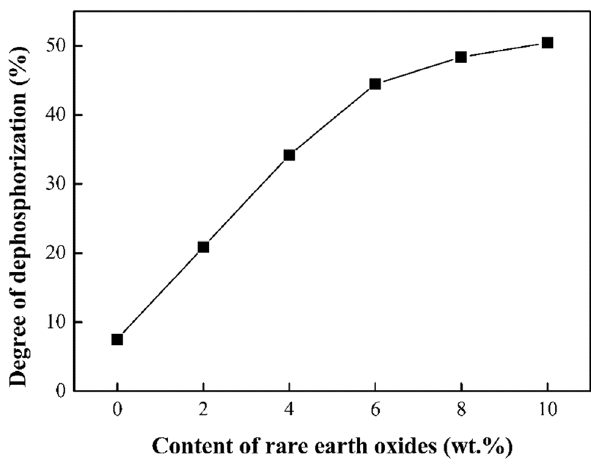
Figure 5: Relationship between dephosphorization e ffi ciency and quantity of